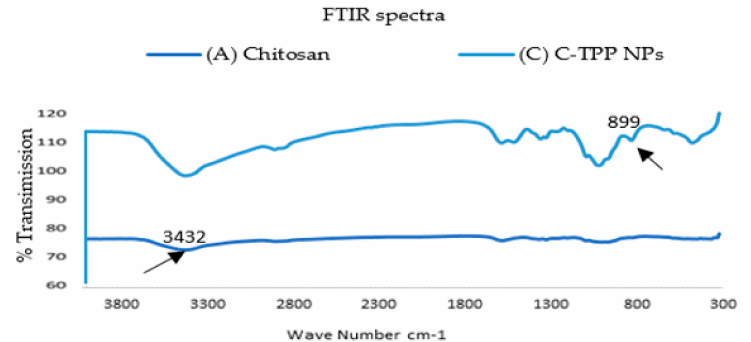
Figure 1. Fourier transform infrared (FT-IR) spectra for ( A ) Chitosan Extract, ( B ) C-TPP